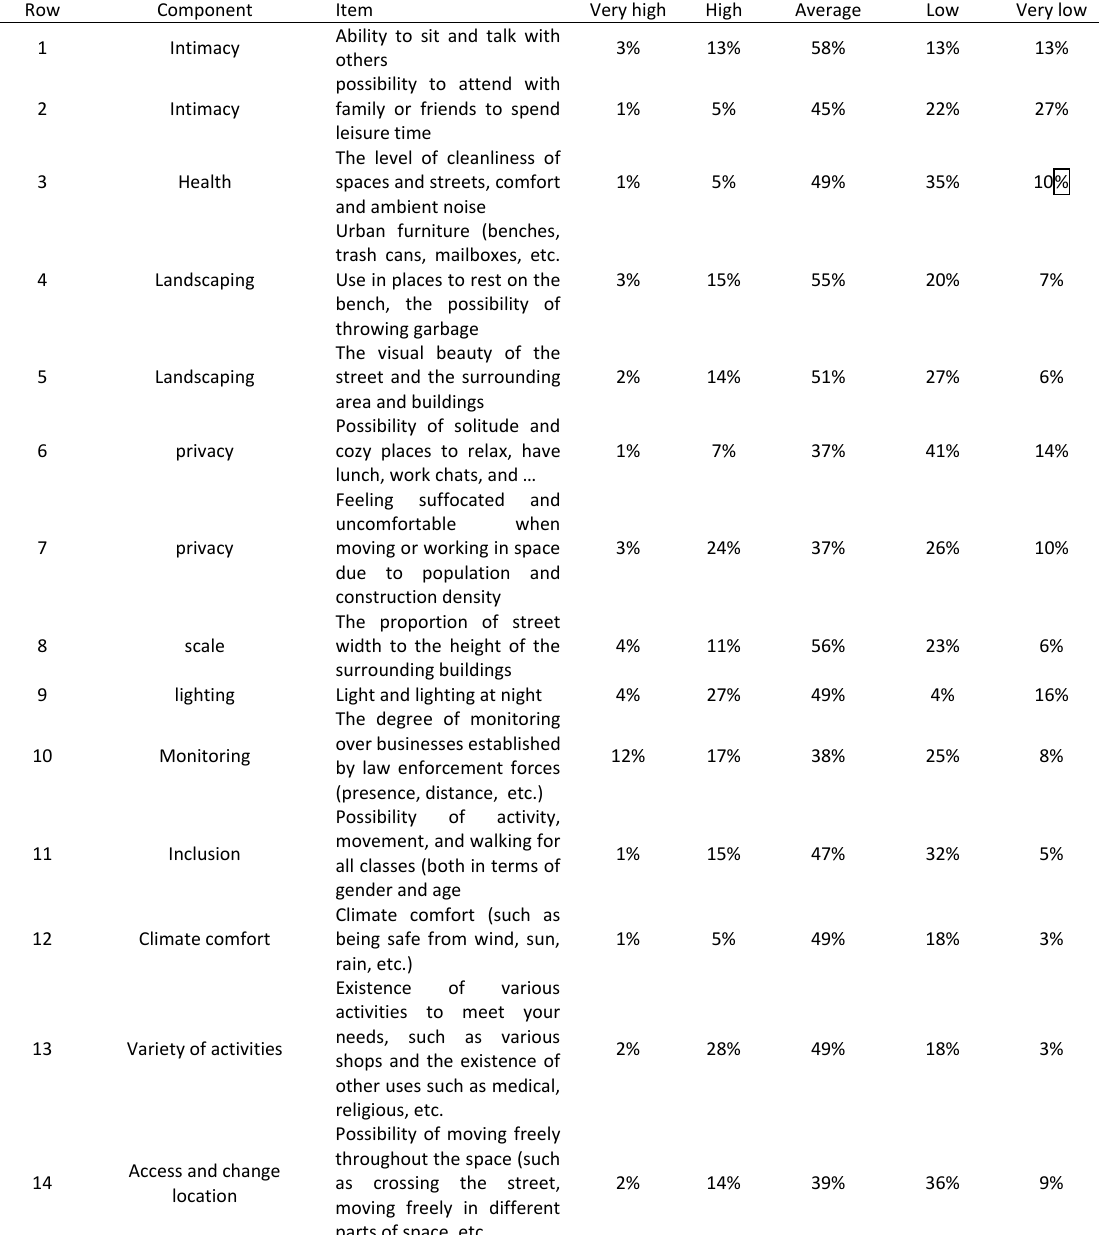
Very low Low Average High Very high Item Component Row